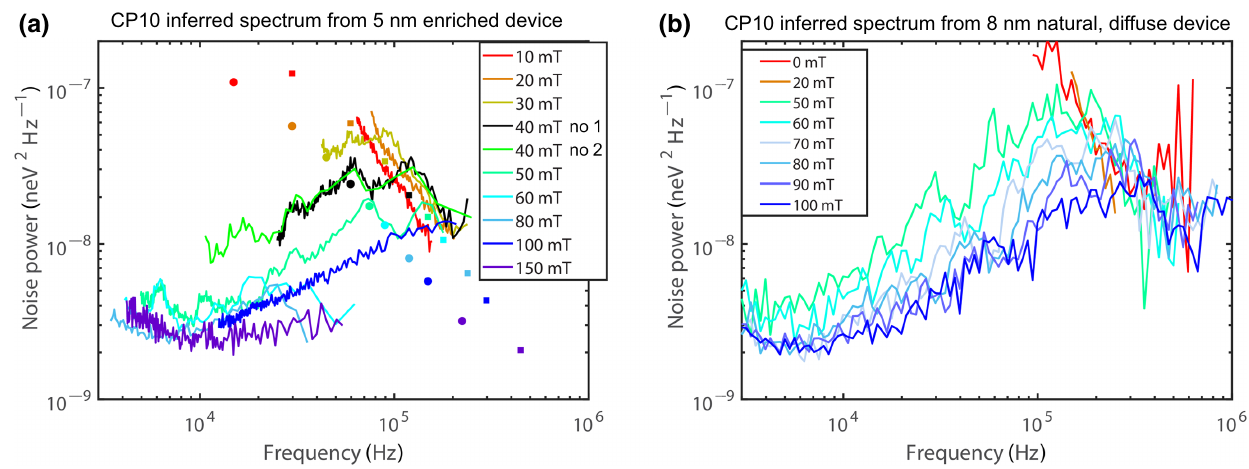
FIG. 7. (a) Inferred magnetic gradient noise from the CP10 data in Fig. 4 using Eq. (7). The circles show the locations of the 73 Ge Larmor peaks and the squares their first harmonic. These points are the same as those plotted in Fig. 9(b). (b) Same as (a), but from a device with an 8 nm well with natural 29 Si content and a more diffuse Si/SiGe